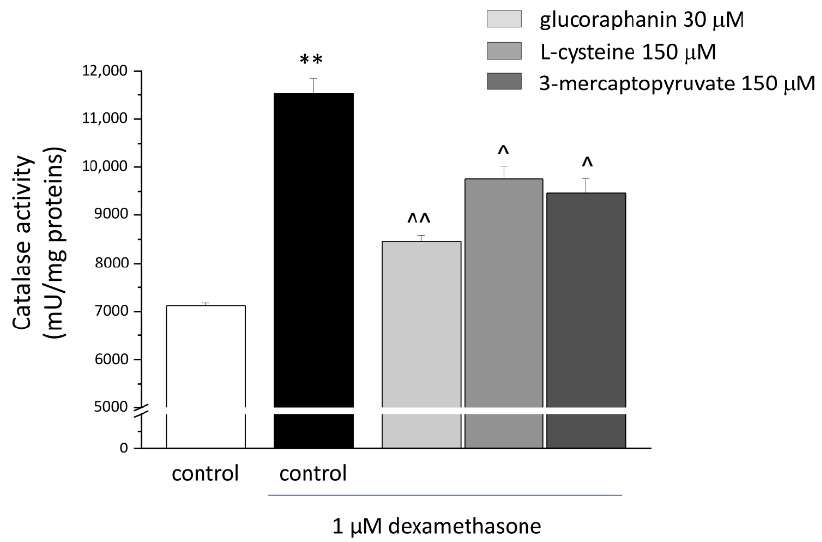
versus DEX). As shown in Figure 5, protein carbonylation was significantly prevented by all of the three compounds (ˆ p < 0.05 versus DEX for L-cysteine; ˆˆ p < 0.01 versus DEX for glucoraphanin and mercaptopyruvate).